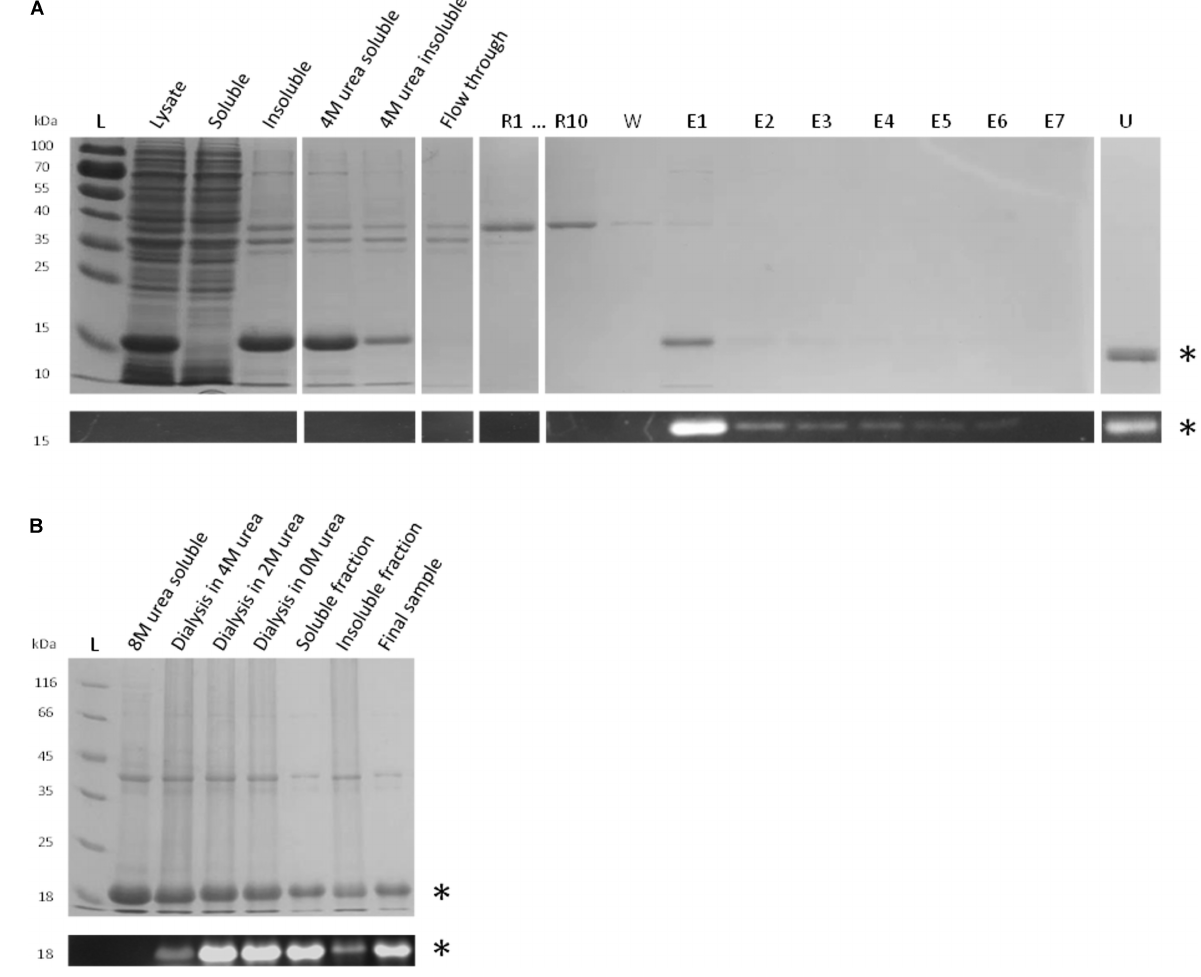
FIGURE 6 | Reconstitution strategies for rFBD. (A) Reconstitution of rFBD by reverse urea gradient on Ni-NTA column. For the reconstitution steps, only the first (R1) and the last sample (R10) are shown. Legend: L, protein ladder; R#, 10 successive gradient steps with decreasing urea concentration; W, wash step; E#, successive eluted samples; U, sample eluted with 4 M urea. (B) Reconstitution of rFBD by dialyzing out urea in a stepwise manner. For both (A,B) , the top panels show Coomassie blue stained gels, while the bottom panels display the same gels under UV illumination. Stars indicate rFBD